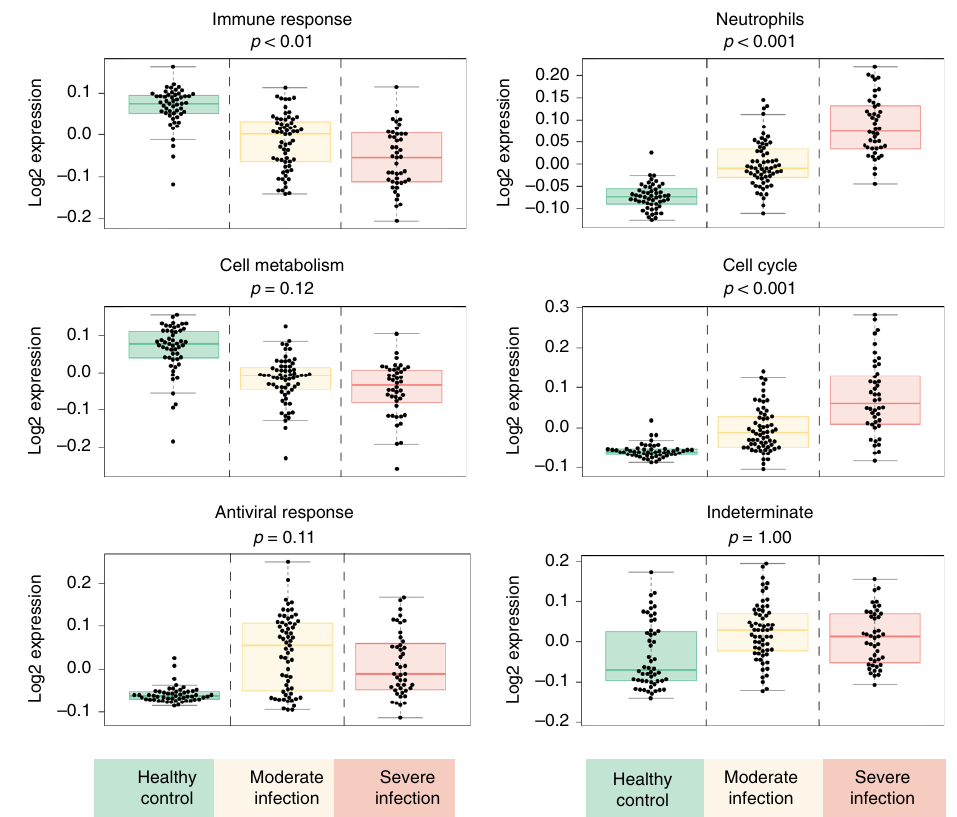
Fig. 5 Analysis of variance of expression levels (eigengene) of six main modules. Boxplots of eigengene values of six main modules. p Values indicate statistically signi fi cant differences between moderate and severe in fl uenza (Bonferroni correction for multiple testing). Y -axis shows normalized log 2 expression levels. Box center line: median, box limits: upper and lower quartiles, whiskers: 1.5× interquartile range. The source data are available in Gene Expression Omnibus (GSE